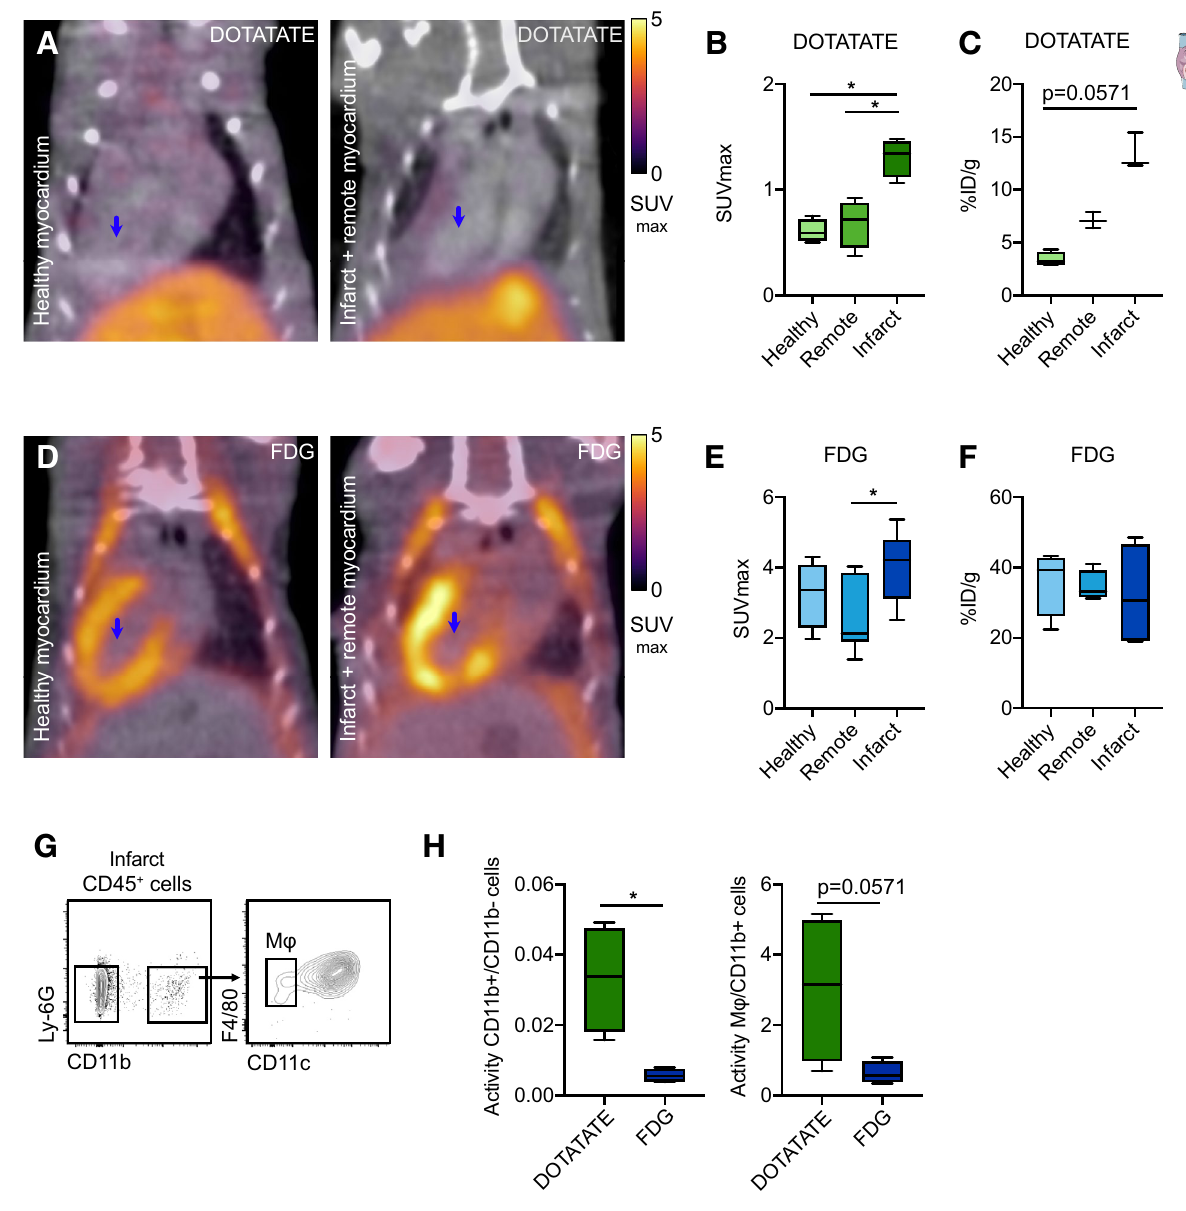
Figure 3. [ 64 Cu]Cu-DOTATATE PET imaging of murine myocardial infarction. ( A ) Representative fused [ 64 Cu]Cu-DOTATATE PET/CT 3D-rendered images of healthy (left) and LAD-ligated (right) animals. Blue arrows represent region of infarct. ( B ) [ 64 Cu]Cu-DOTATATE SUV max (in vivo) and ( C ) %ID/g (ex vivo) in the heart of C57Bl/6 healthy animals (myocardium) and LAD-ligated mice (remote and infarct). N = 4 per group. ( D ) Representative fused [ 18 F]F-FDG PET/CT 3D-rendered images of healthy (left) and LAD-ligated (right) animals. Blue arrows represent region of infarct. ( E ) [ 18 F]F-FDG SUV max (in vivo) and ( F ) %ID/g (ex vivo) in the heart of C57Bl/6 healthy animals (myocardium) and LAD-ligated mice (remote and infarct). Controls N = 4 and infarcted N = 6. ( G ) Representative flow cytometry plots identifying CD11b − , CD11b + and macrophage cell populations in the myocardium. ( H ) Quantification of activity per cell in the infarcted myocardium. Data are expressed as ratio of CD11b + /CD11b − (left) and Mφ/CD11b + cell activity (right). N = 4 per group. DOTATATE: [ 64 Cu]Cu-DOTATATE; FDG: [ 18 F]F-FDG; infarct: infarcted region of the myocardium; ID: injected dose; Mφ: macrophages; Myocardium: healthy C57Bl/6 myocardium; remote: remote myocardium (non-infarcted); SUV max : maximum standardized uptake value. CD11b + cells represent CD11b + CD11c hi , excluding macrophage population. * p < 0.05. Data are presented as median (interquartile